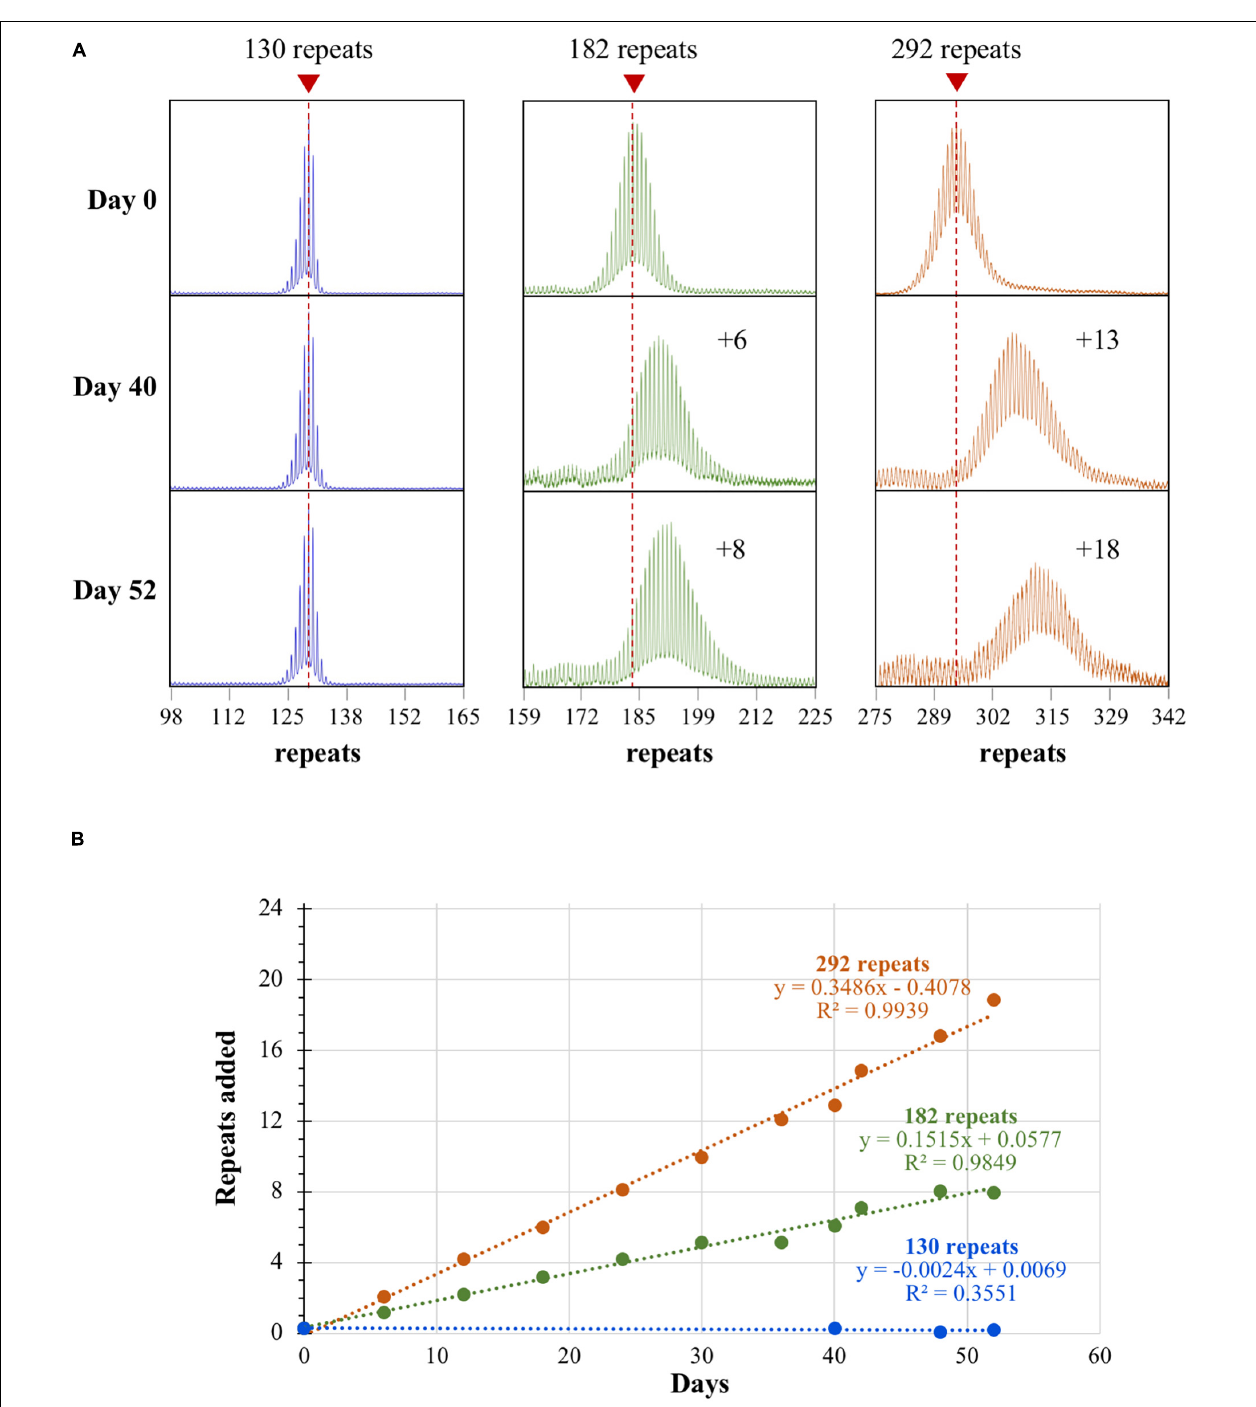
FIGURE 1 | Repeat expansion in mESCs with different numbers of CGG repeats. (A) Repeat PCR profiles for cell lines with 130, 182, and 292 repeats after 0, 40, and 52 days in culture. Dashed lines represent the initial allele size at day 0. (B) Graph showing the change in repeat number over time for the 3 mESC lines shown in (A)